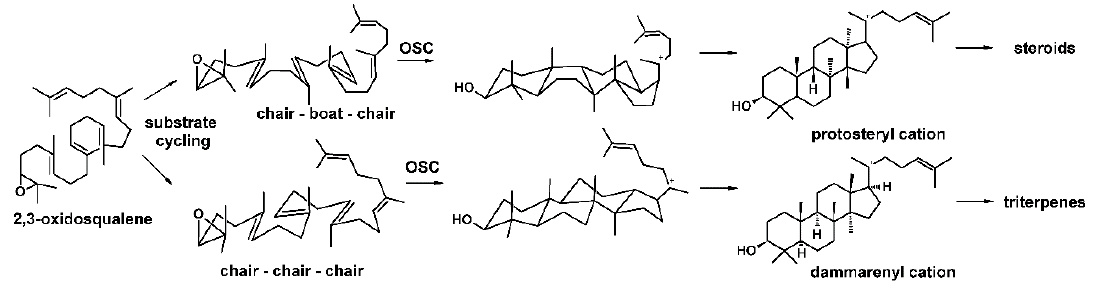
Figure 1. Schematic biosynthesis of the key triterpene and sterol intermediates from 2,3 ‐ oxidosqualene cyclization [8,9].